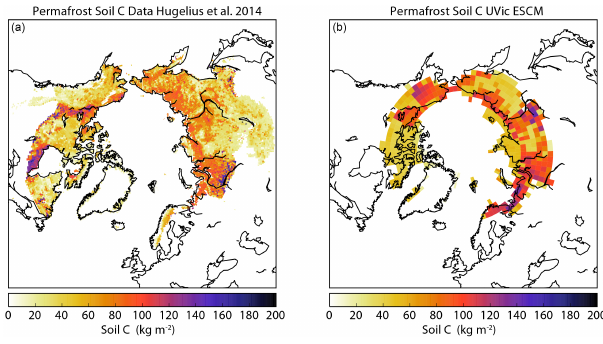
Figure 1. Comparison of the estimated soil carbon density in the top 3m of soil in the northern hemispheric permafrost region from Hugelius et al. (2014) and soil carbon density in the top 3.35m of soil in the permafrost region of the UVic ESCM. The permafrost region in the UVic ESCM is defined as the area where the model simulates at least one soil layer that is perennially frozen at the be- ginning of the model integration in year 1850. The model is able to capture the correct global total of soil carbon though tuning but with significant spatial